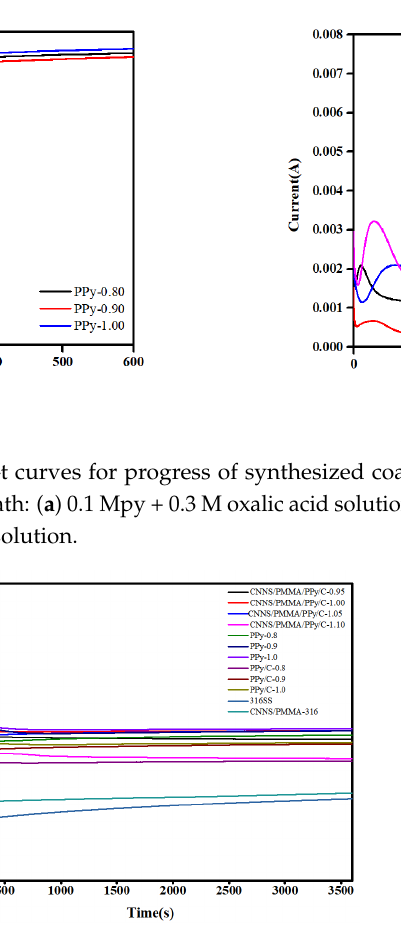
Figure 1. I–t curves for progress of synthesized coatings at di ff erent potentials in a magnetically stirred ice bath: ( a ) 0.1 Mpy + 0.3 M oxalic acid solution; ( b ) 0.1 Mpy + 1 g/L graphite powder + 0.3 M oxalic acid solution.